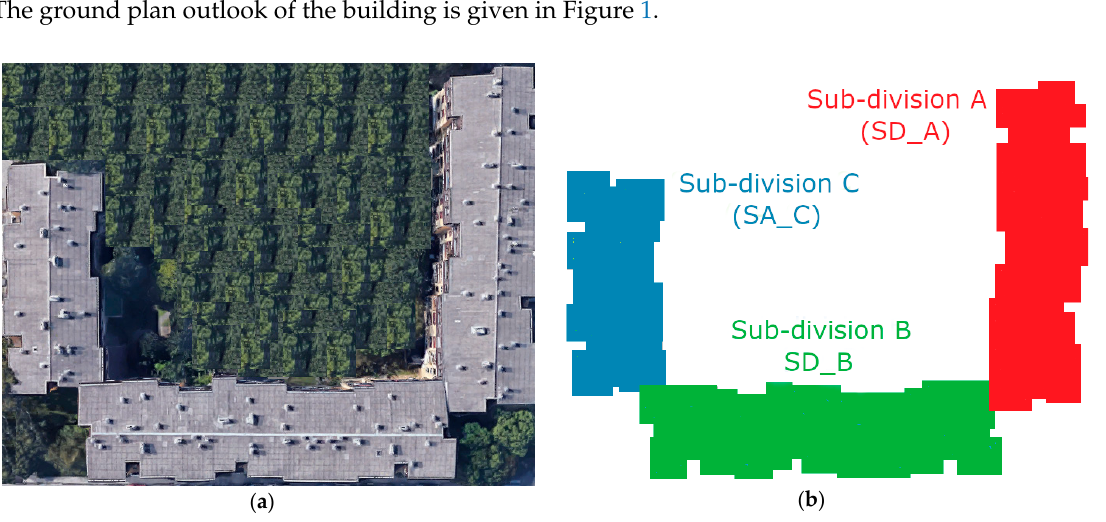
Figure 1. Ground floor plan of the analysed building: ( a ) Satellite image from Google Maps; ( b ) A sketch of the ground plan with the annotations of the each subdivision.